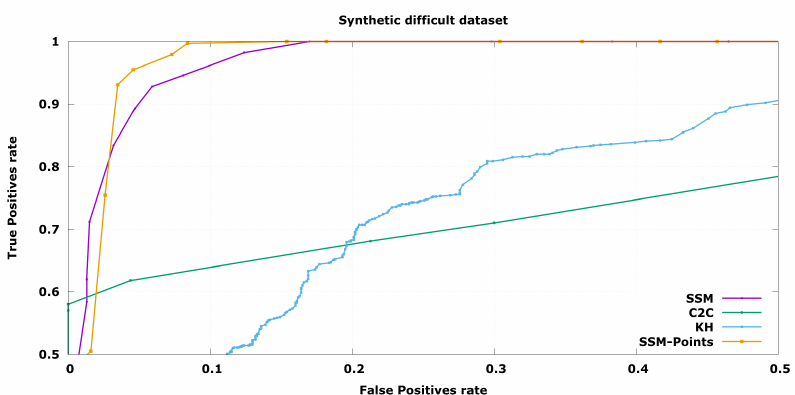
Figure 7. ROC curve for synthetic object classification between the Good and Difficult validation sets synthetically